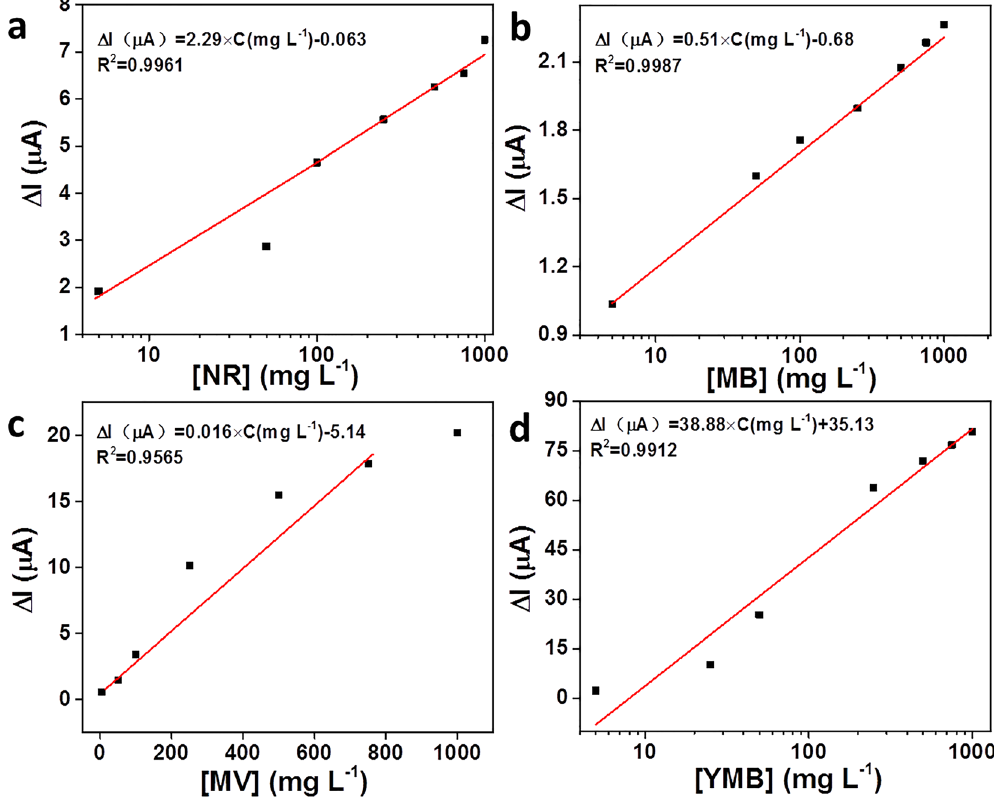
Figure 7. Corresponding plot of the change of maximum peak current ( Δ I) as a function of the concentration of ( a ) NR, ( b ) MB, ( c ) MV and ( d ) YMB, respectively. Error bars mean standard deviation (n =